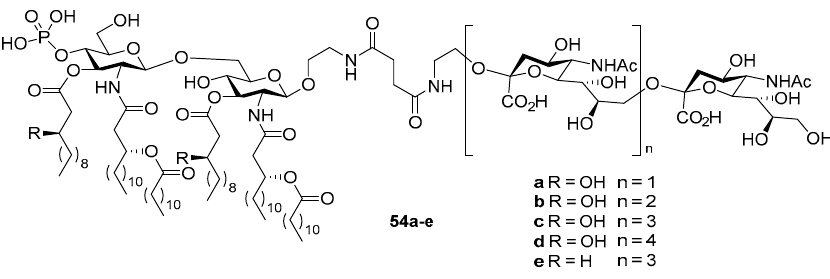
Figure 3. Conjugates of N. meningitidis MPLA with polysialic acids as group C meningitis vaccine candidates.